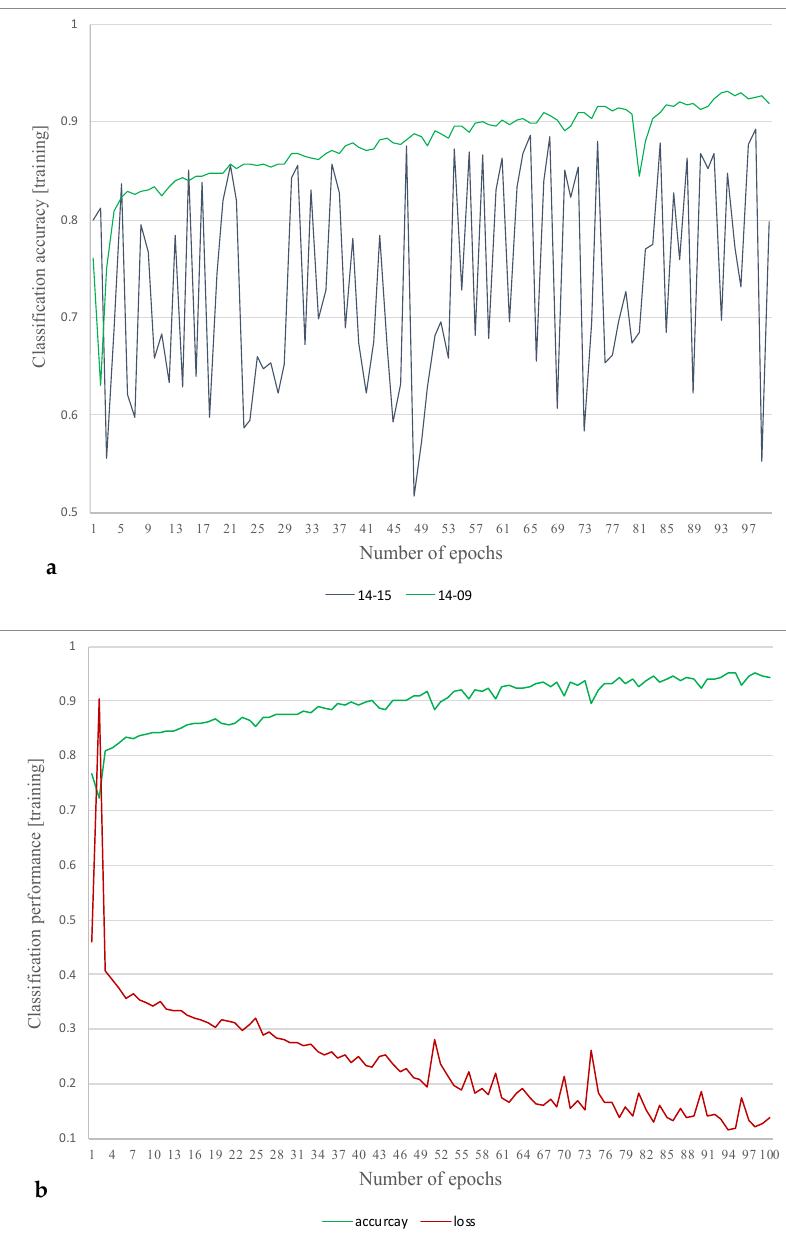
Figure 7. CNN-GA classification performance for selected individuals during training. ( a ) Selected individuals “15” and “09” from generation 15; ( b ) best-performing model overall of all 19 generations (individual identifier: 14–15).